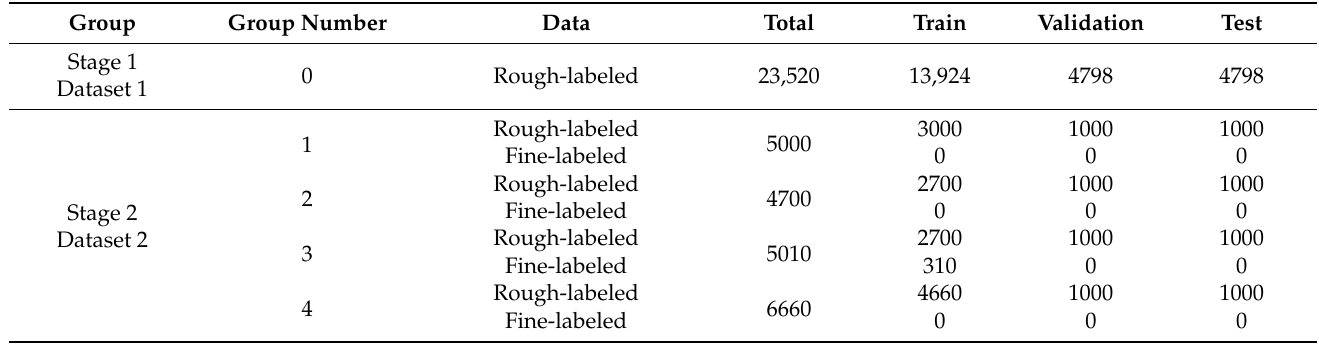
Table 1. Experiment setting.